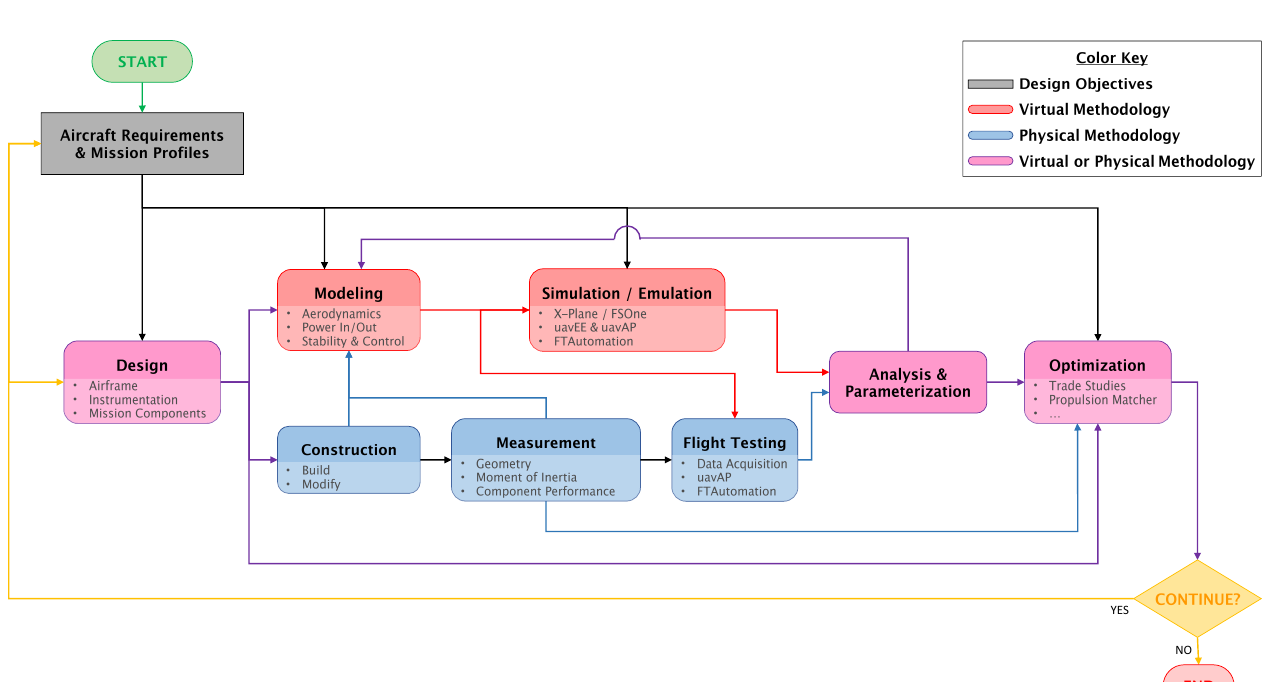
Figure 1. A functional diagram of the UAV Development